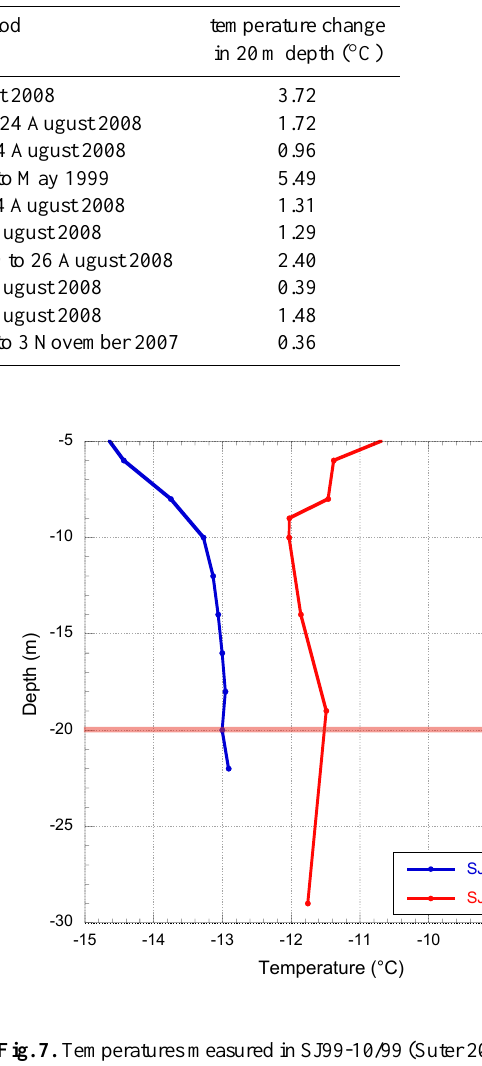
Fig. 6. Temperatures measured in CG95-1/97 (L¨uthi 2000), com- pared with the new measurements at CG08-3/08 at Colle Gnifetti.